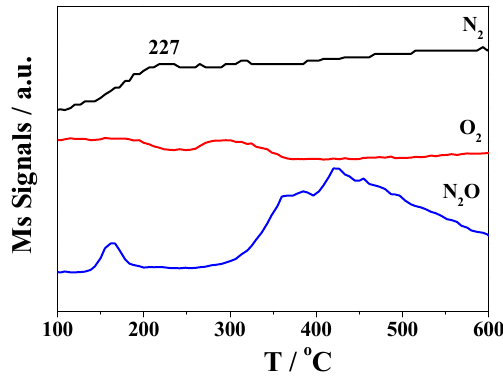
Figure 12. N 2 O ‐ TPD ‐ MS profiles of Ru/Al 2 O 3 ‐ NaBH 4 . Detection signals: 28 (N 2 ), 32 (O 2 ) and 44 (N 2 O).